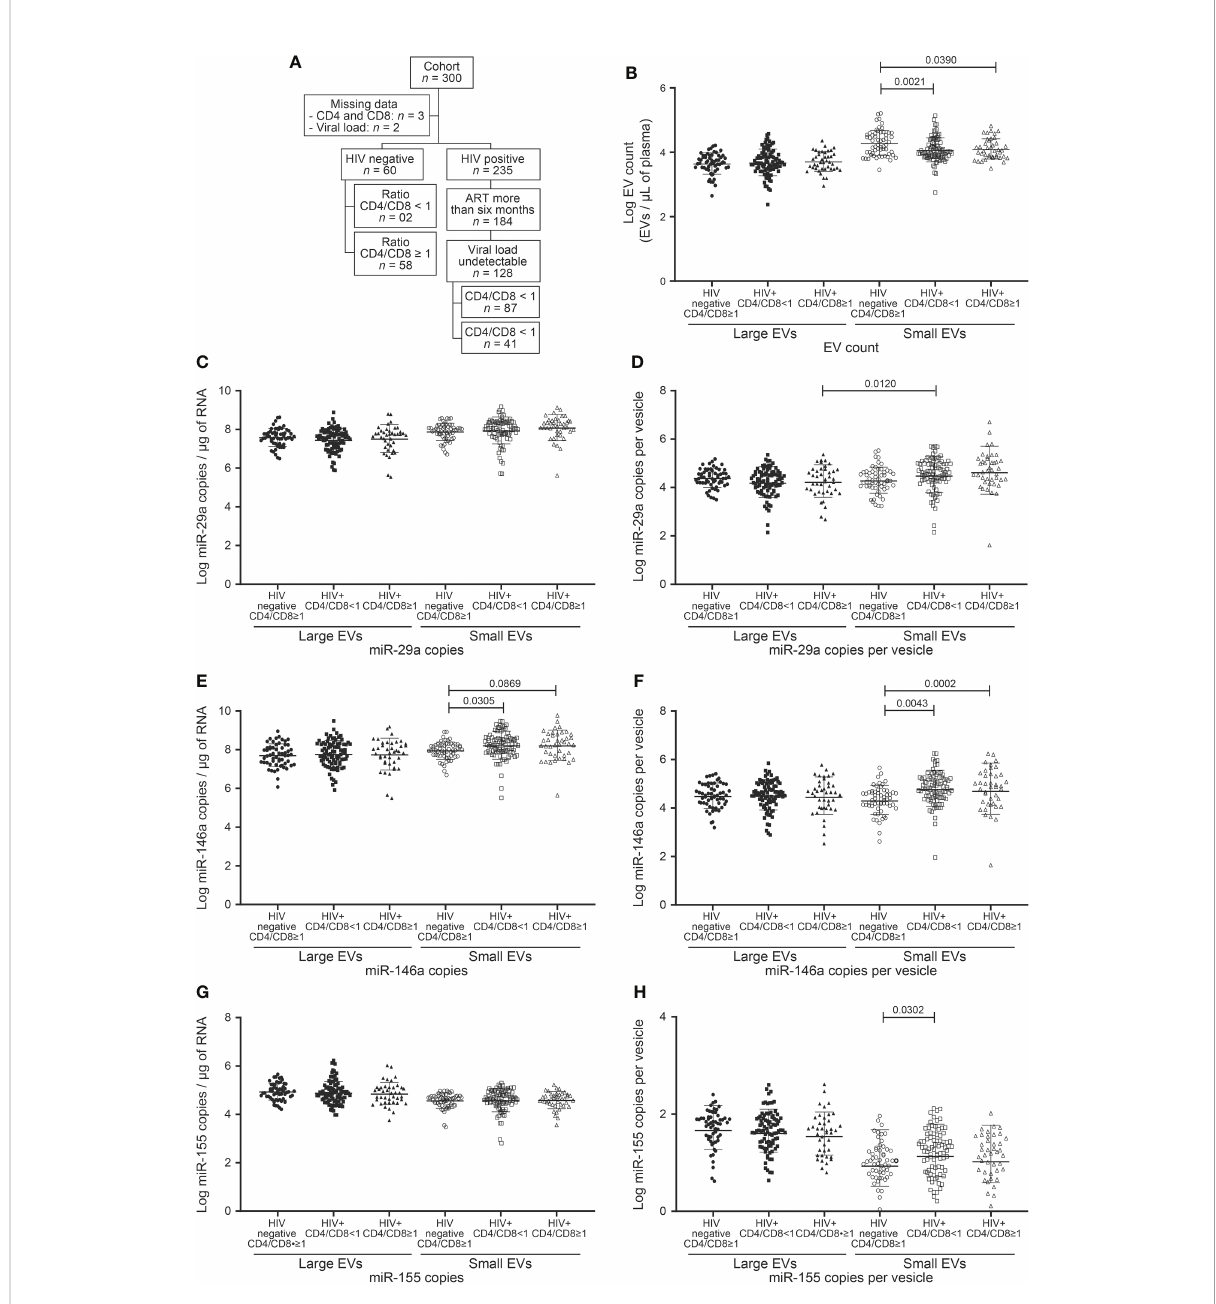
FIGURE 2 EVs count and miRNAs expression in study participants following to ratio CD4/CD8 T cells count. (A) Flow chart of study participants included in the analysis based on ratio CD4/CD8 T cells count. (B) Large and small EVs particles number quanti fi cation in fl ow cytometry analysis. (C, D) , (E, F) , and (G, H) present respectively EVs miR-29a, miR-146a, and miR-155 quanti fi cation and expression as copies per µg of RNA and copies per vesicle. An ordinary one-way ANOVA with Tukey ’ s multiple comparisons test was used for comparison between